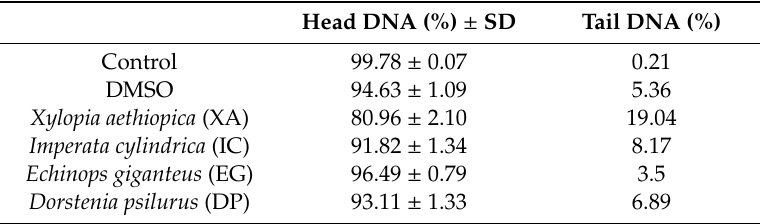
from Carl Roth GmbH & Co. (Karlsruhe, Germany). Roswell Park Memorial Institute (RPMI)